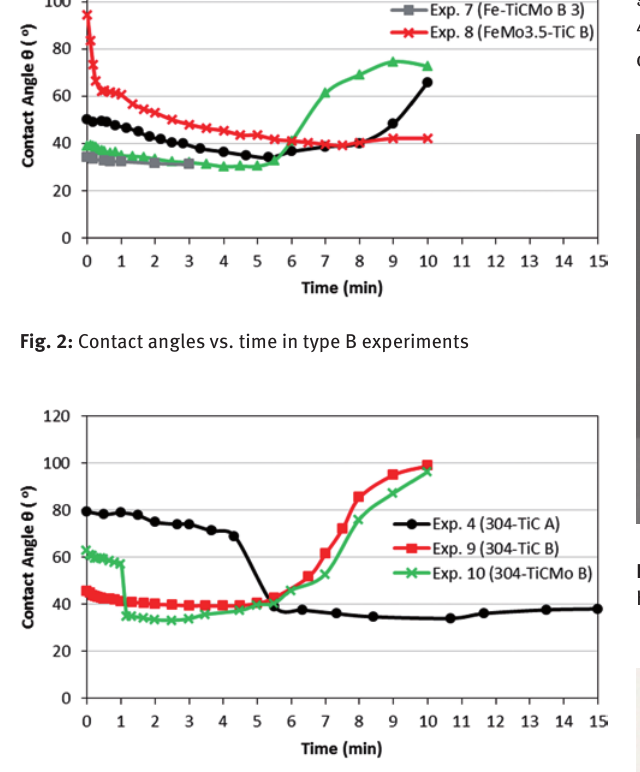
Fig. 3: Contact angles in experiments with stainless steel